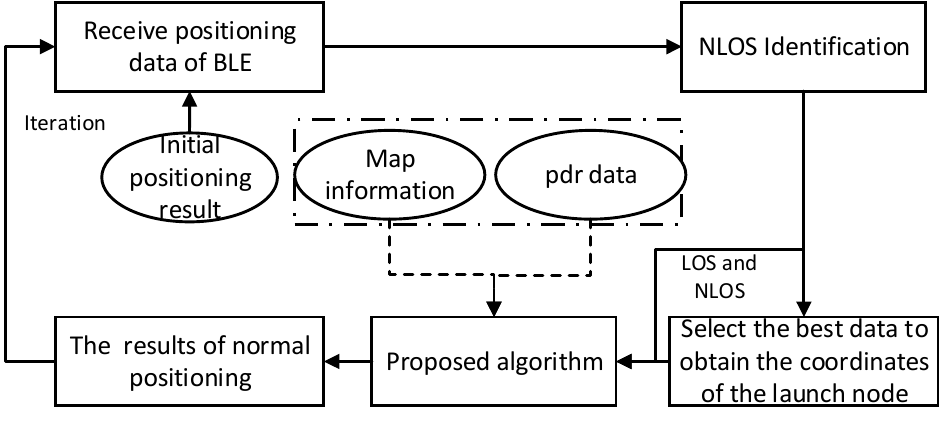
Figure 3. The normal positioning process.